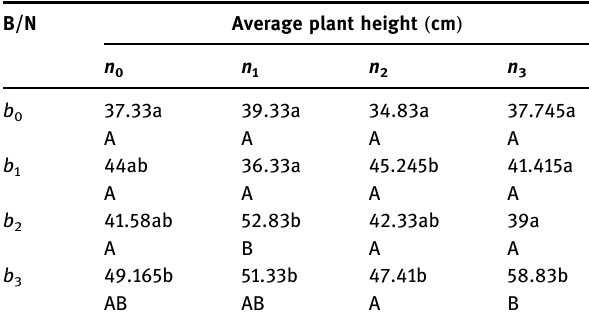
Table 4: Fermented compost and N - fertilizer on length of fruit, diameter of fruit, number of fruit per plant, and weight of fruit